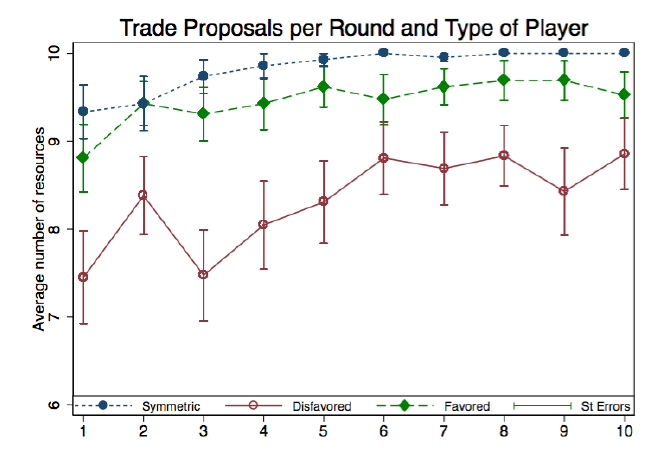
Figure A2. Mean trade proposals per round and type of player in the symmetric and asymmetric price treatments with standard errors. The disfavored party is defined as the buyer in the seller-favoring- treatment and the seller in the buyer-favoring-treatment and vice-versa for disfavored